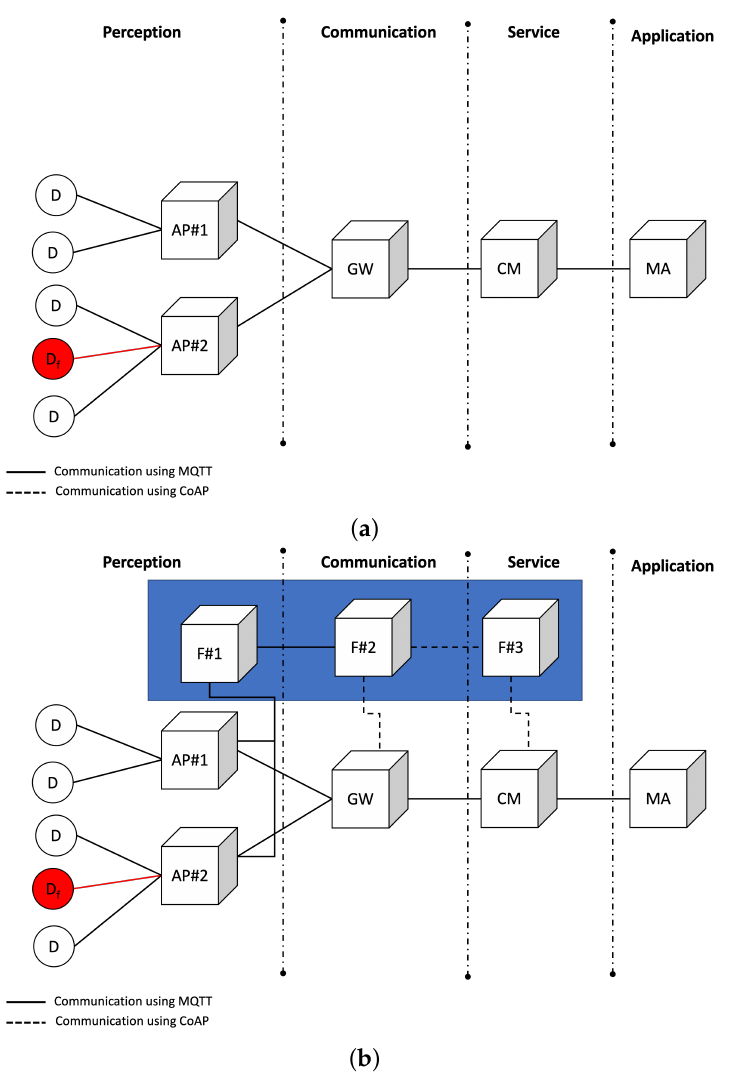
Figure 5. System architecture for experimental evaluation. ( a ) Experimenting system architecture without FaTEMA. ( b ) Experimenting system architecture with